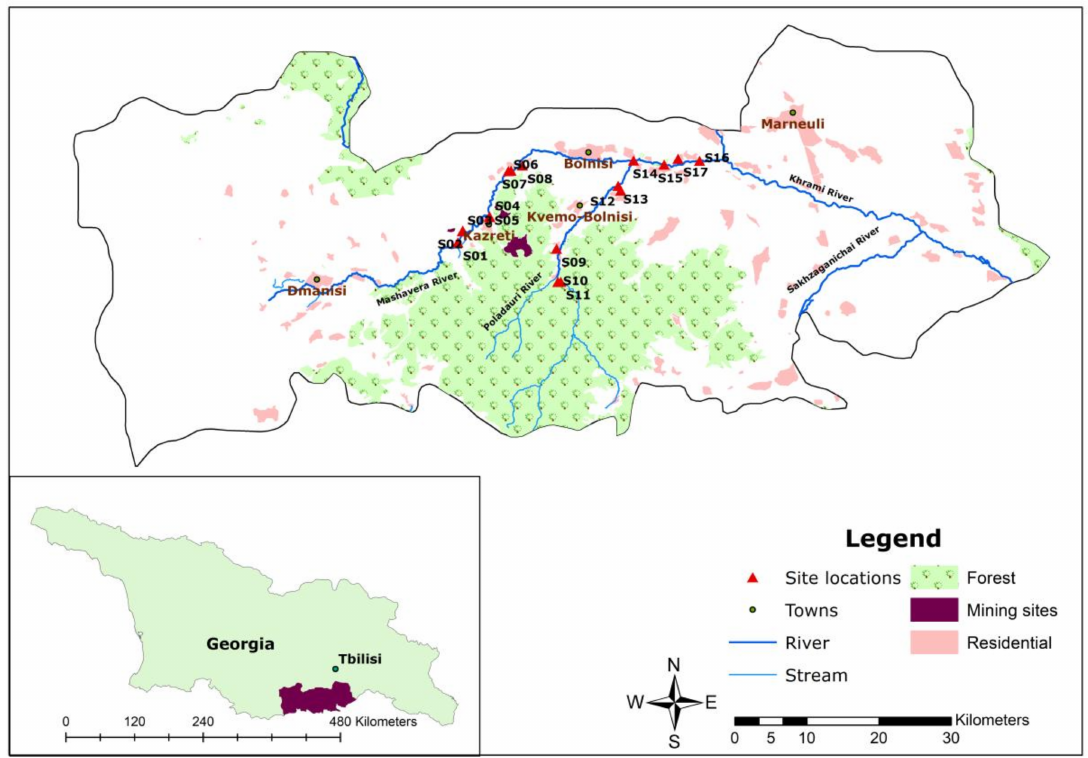
Figure 1. Map of the study area (Authors’ illustration). GIS Data sources: 1. Administrative boundaries [24] and 2. Land-use data and stream data